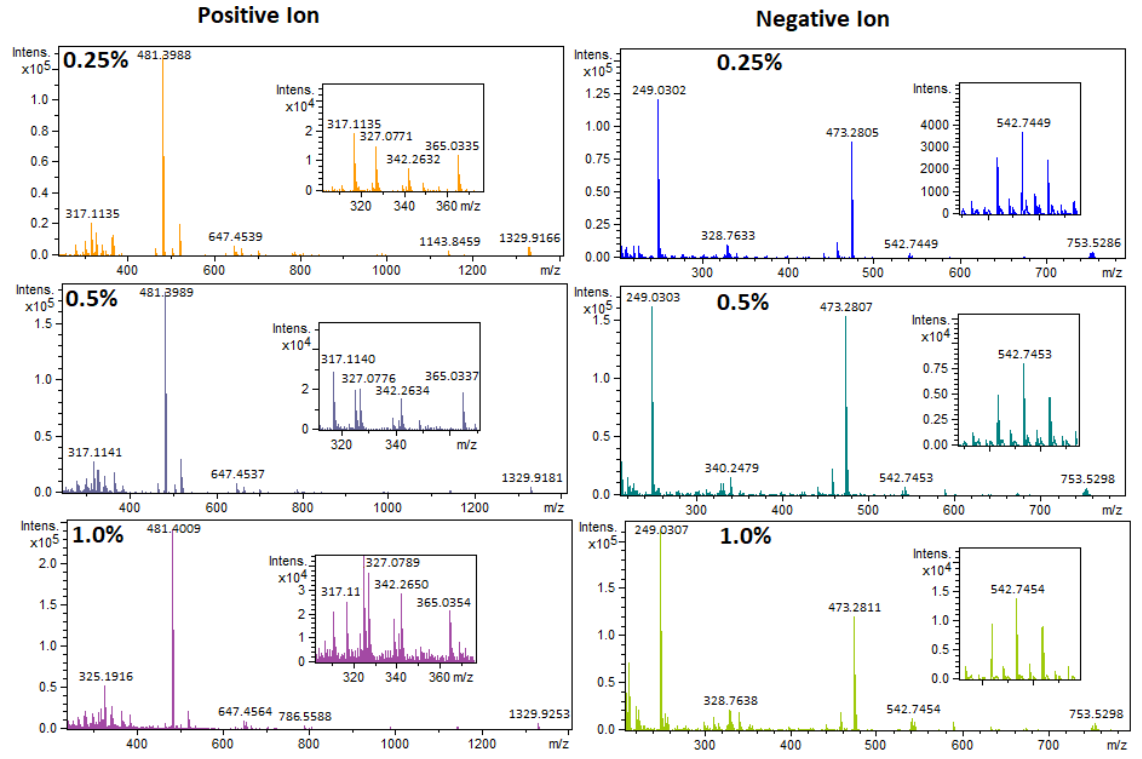
Figure 1. AP-MALDI-qTOF-MS full-scan mass spectra of a standard mixture (Table S1) measured on three different GNP-doped UP AP-MALDI target plates. Top; 0.25 wt.% GNP, middle; 0.5 wt.% GNP, and bottom; 1.0 wt.% GNP. Left: positive ionization mode. Right: negative ionization mode.